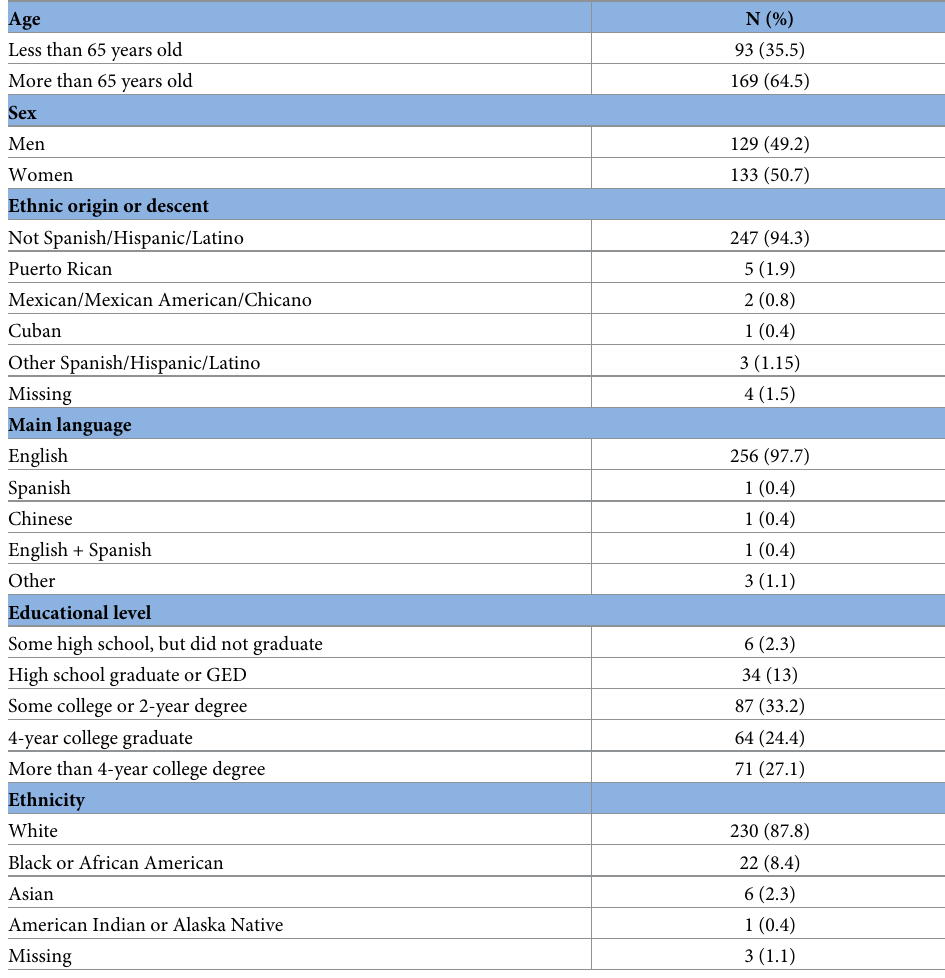
Table 1. Demographic information (N =